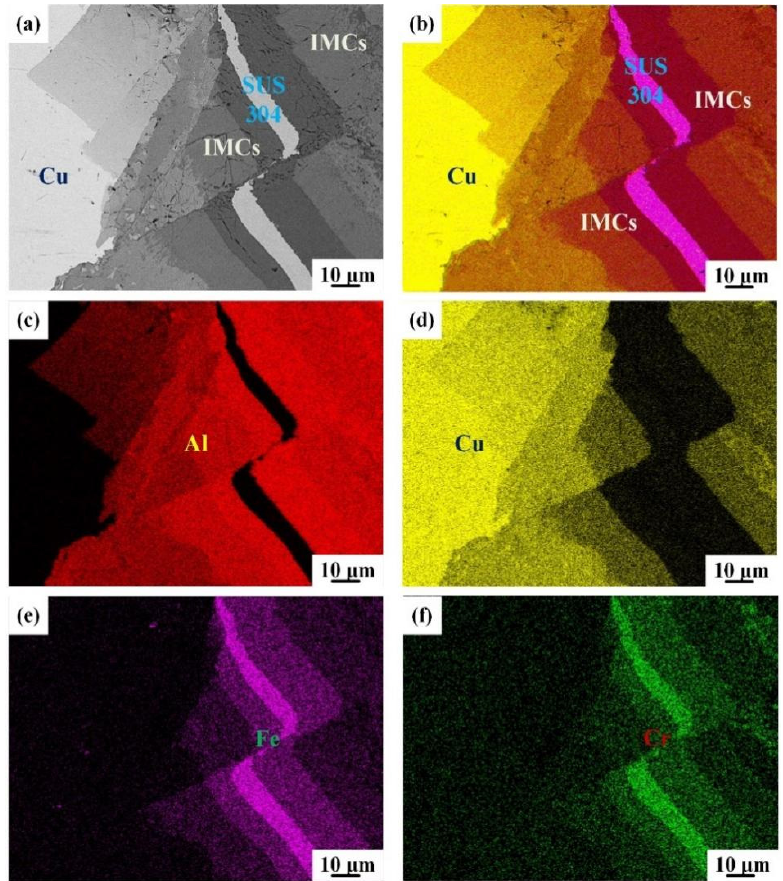
Figure 4. SEM images of bonding interface for IFR-600 ( a ) and the corresponding EDS mapping: ( b )